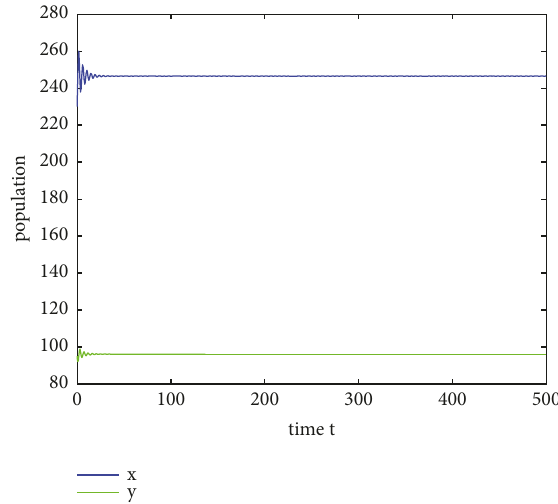
Figure 12: A Time series diagram for prey and predator. The figure depicts local stability of the interior equilibrium for the delayed model (3) with the time delay 𝜏 1 = 𝜏 2 = 0.1 , where the other parameter values are 𝑥(0) = 230 , 𝑦(0) = 95 , 𝐴 = 0.01 , 𝑟 = 2.65 , 𝐾 = 900 , 𝑎 = 0.02 , 𝑐 = 0.215 , and 𝑚 = 1.06